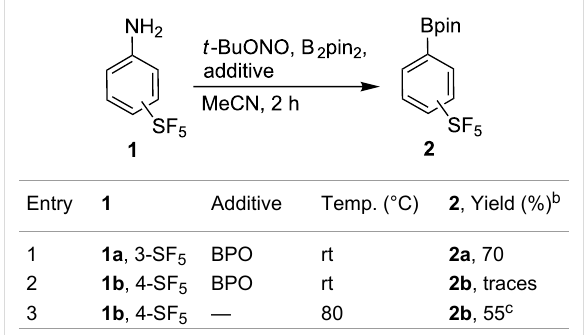
Table 1: Synthesis of boronates 2 from aniline derivatives 1 a